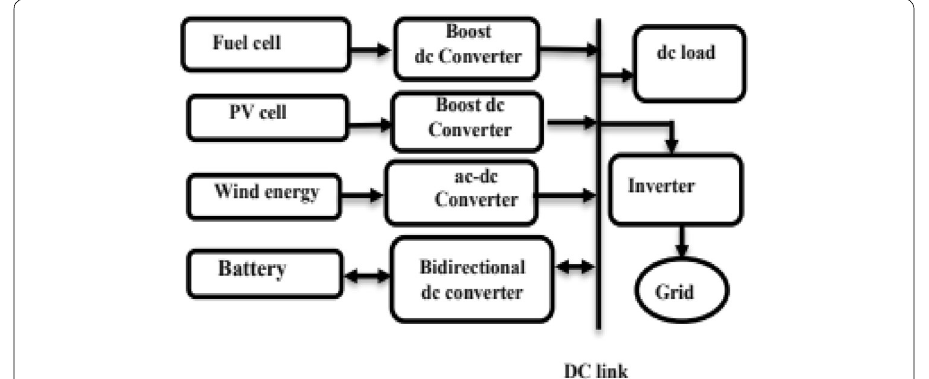
Fig. 1 Hybrid energy system with battery interface using bidirectional DC–DC